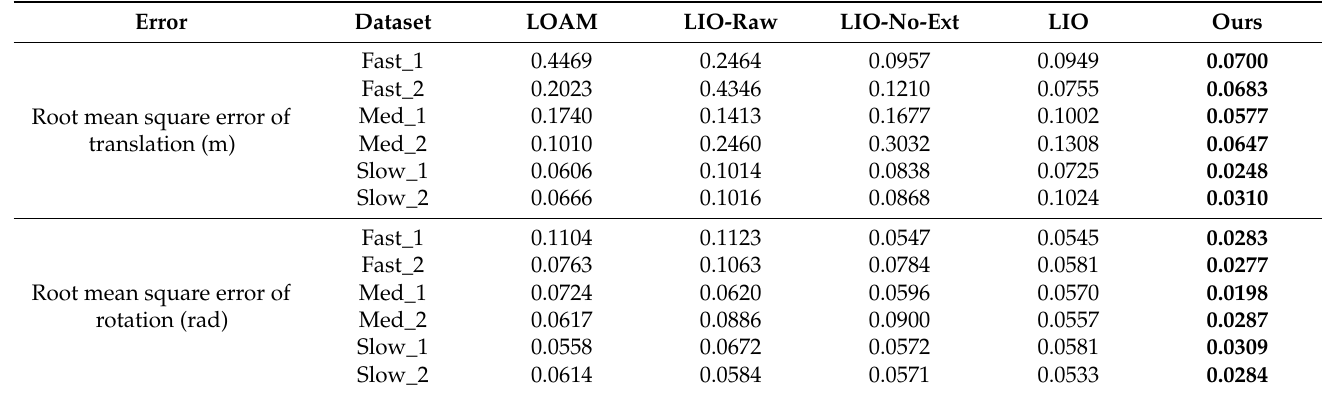
Table 2. Rotation and translation errors for comparing true values in the following six fast-to- slow datasets.